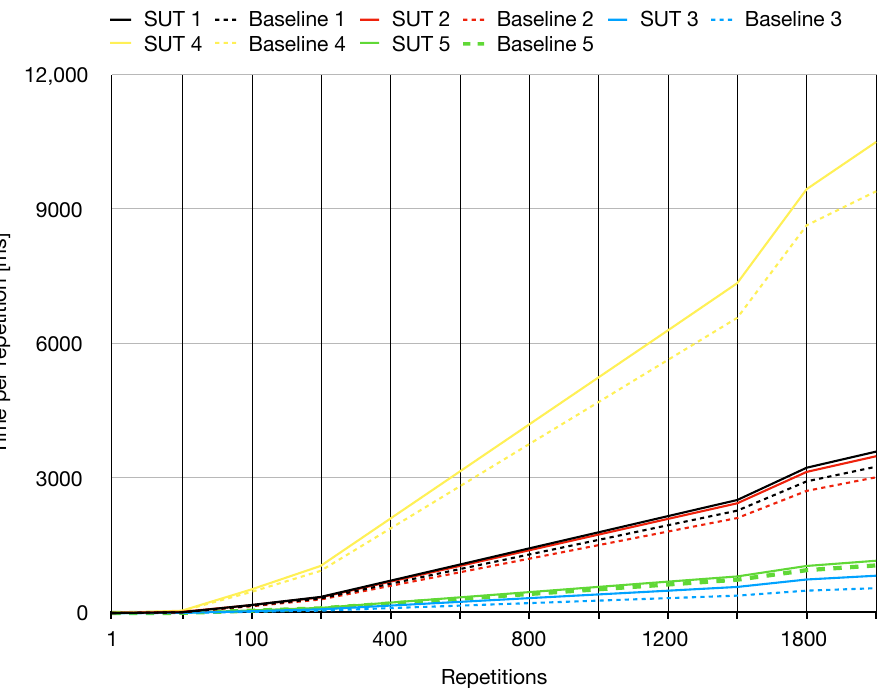
Figure 13. Results of repeated test execution for the benchmark